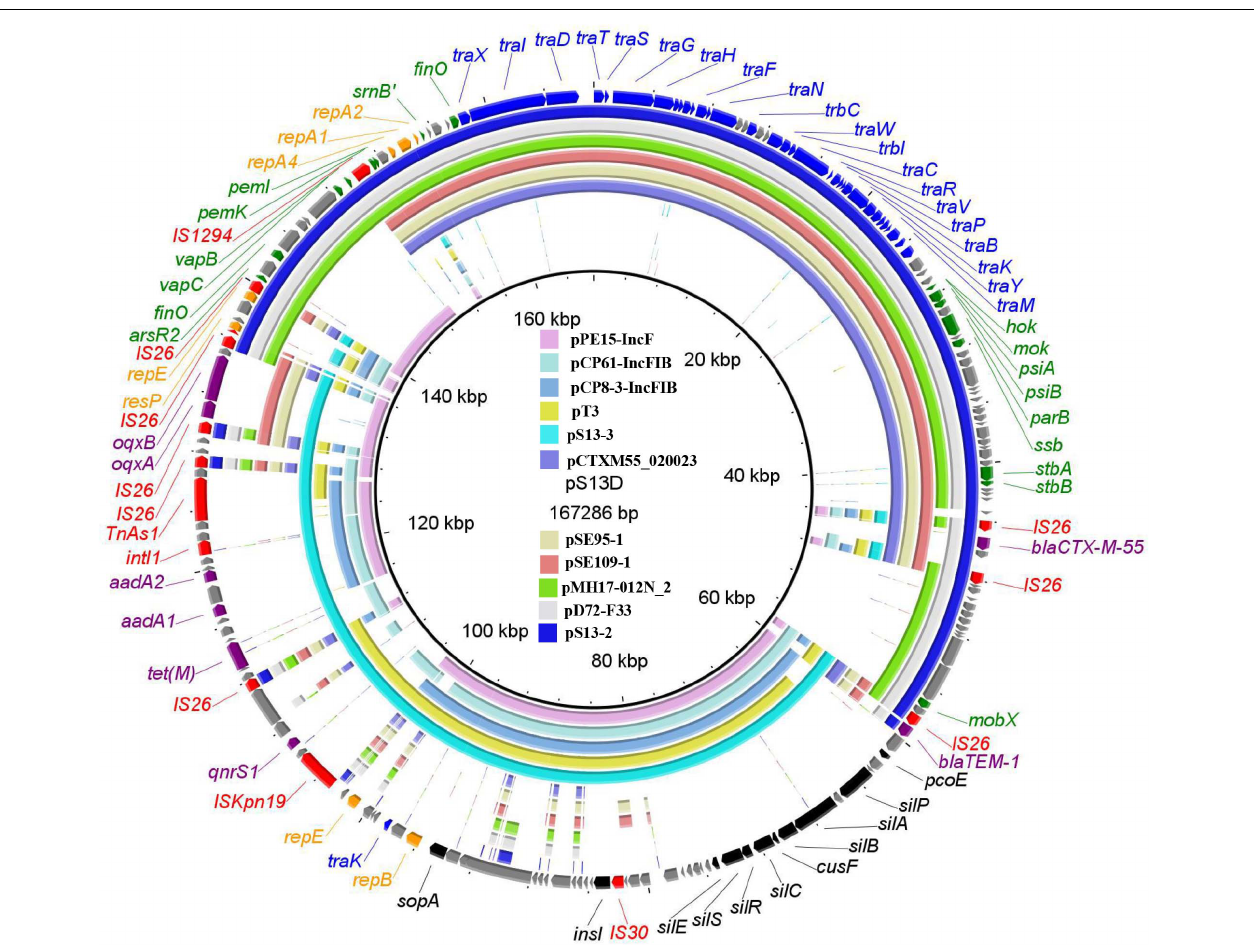
FIGURE 1 | The whole-plasmid sequence of pS13D and comparisons of pS13-2 and pS13-3, with similar plasmids. The outer ring comprises the CDSs of pS13D. The plasmids in this study included pS13D (MT657397), pS13-2 (CP047092), pS13-3 (CP047093), pCTXM55_020023 (CP025949), pSE95-1 (CP050717), pSE109-1 (CP050710), pMH17-012N_2 (AP018568), pD72-F33 (CP035314), pPE15-IncF (CP041629), pCP61-IncFIB (CP053729), pCP8-3-IncFIB (CP053738), and pT3 (MK656937). Key features of pS13D are highlighted in different colors. Replicon genes are in highlighted in orange, transfer-associated genes in blue, resistance genes in purple, mobile elements in red, virulence related genes in black, and hypothetical proteins in gray.